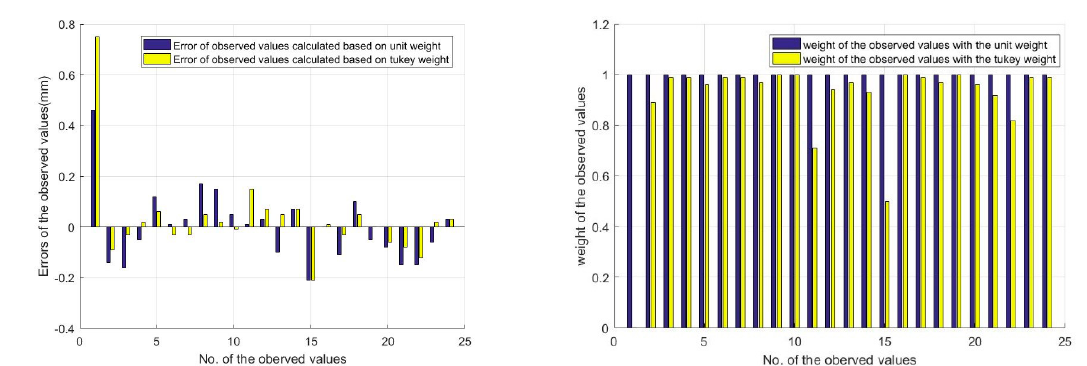
Figure 10. Error and weight of the observation values.